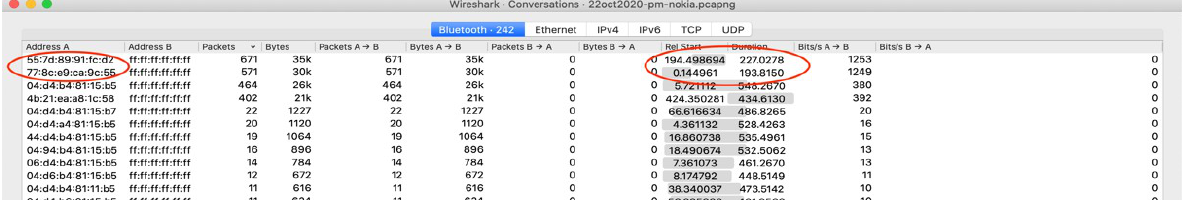
Figure 5. The Wireshark addresses captured.